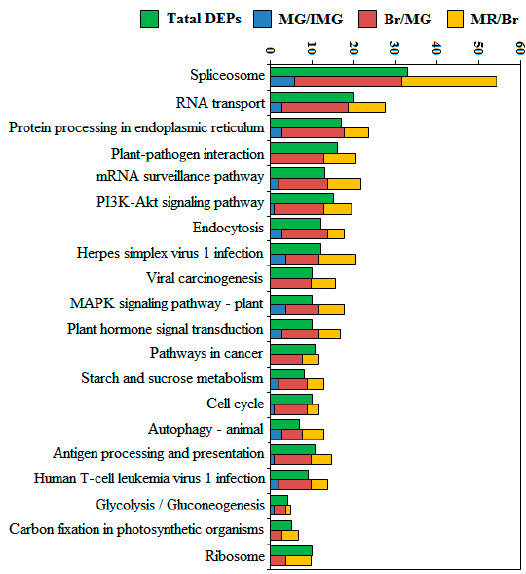
Figure 6. Top 20 KEGG pathways assigned to the DEPPs.